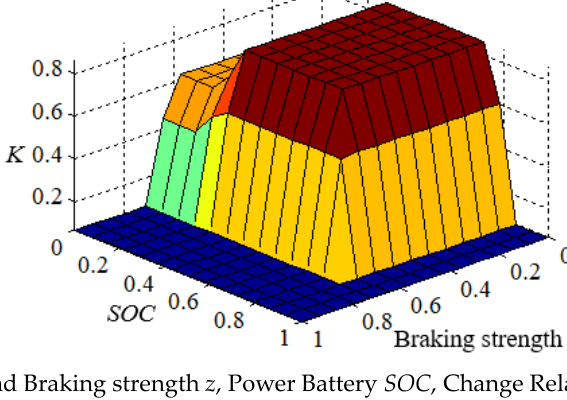
Figure 10. Fuzzy relation between inputs and K .